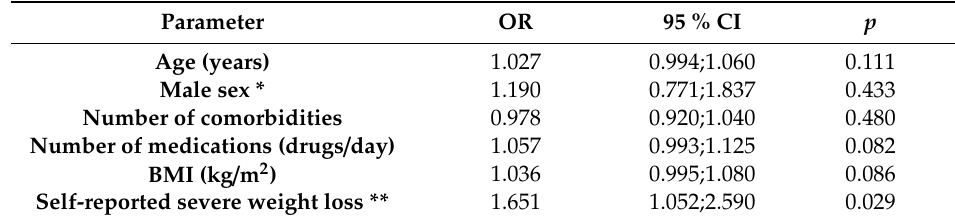
Table 4. Risk factors for moderate / severe fatigue identified by binary logistic regression analyses in the total number of patients (model